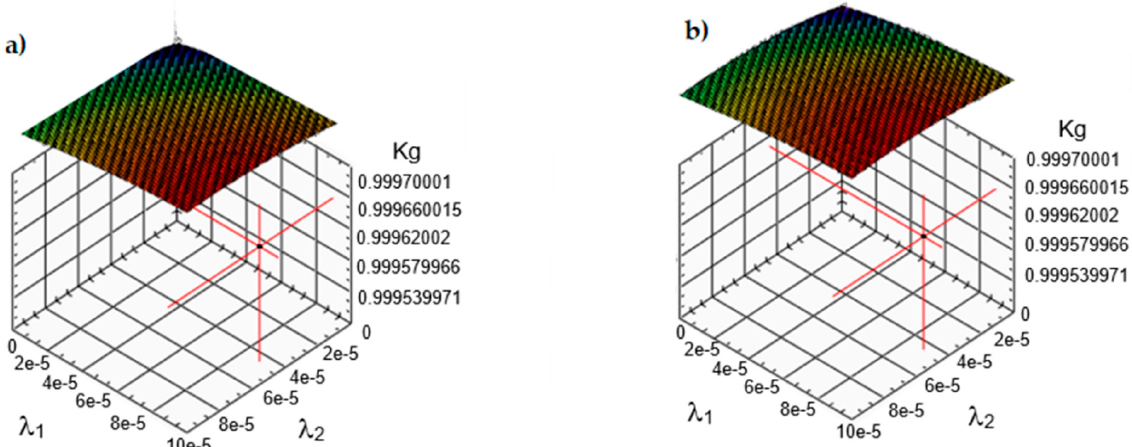
Figure 12. Graphs of the test of the mean time between successive failures, for constant parameters, including: mean repair time 0.7 [h]; mean operating time I type 0.8 [h]); type II mean service time = 1.3 [h], where: ( a ) the mean time between successive failures is 2500 [h]; ( b ) the mean time between successive failures is 3000 [h].